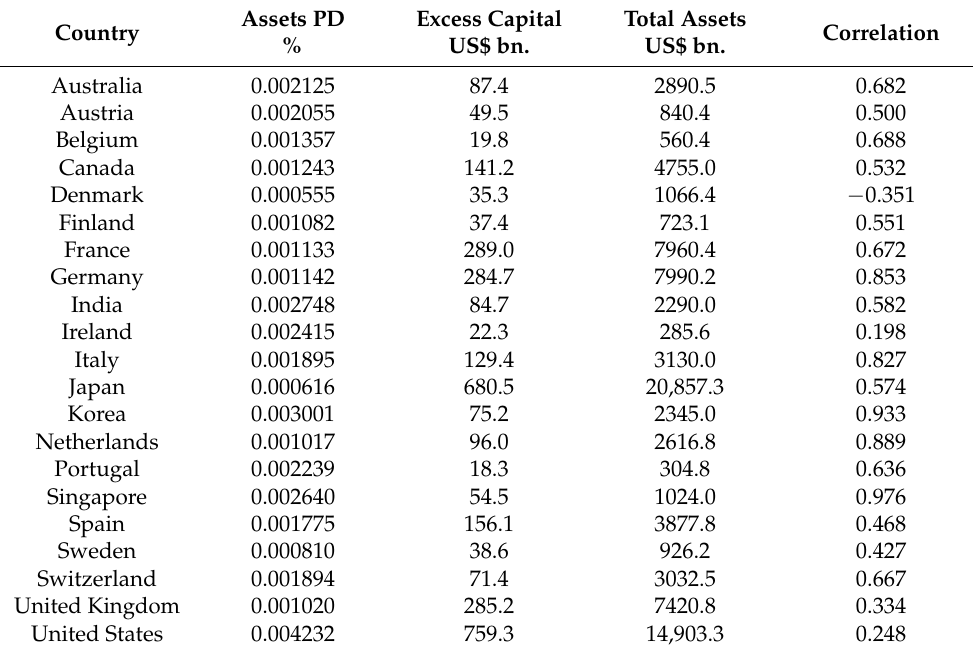
Table 1. Countries’ banking systems data as of